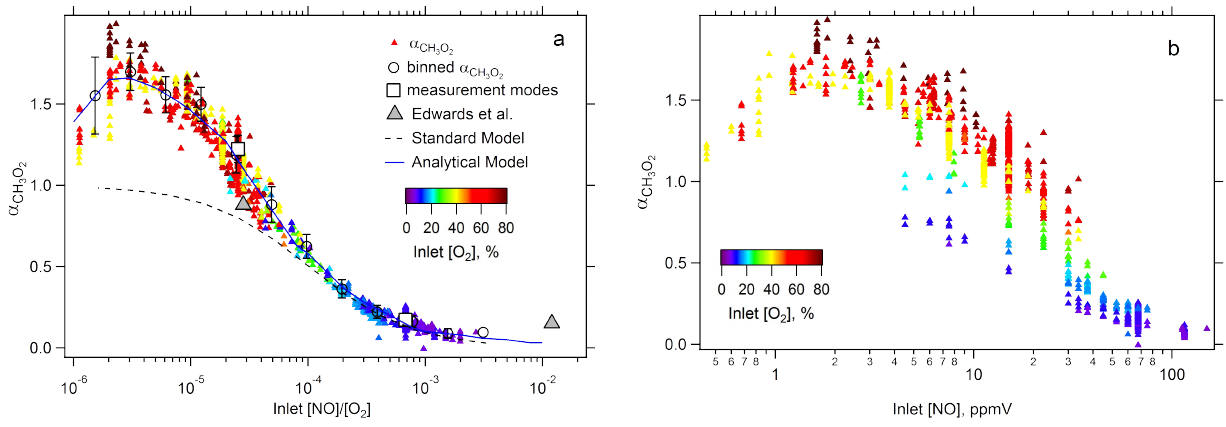
Fig. 3. Plot of measured α CH against (a) the ratio of [NO]/[O 2 ] in the inlet and (b) inlet [NO]. Individual measurements are shown as 3 O 2 small triangles, colored according to inlet O 2 concentration. In (a) the open black circles are the average measured α CH values binned 3 O 2 by [NO]/[O 2 ], with error bars showing the standard deviation for each bin. Squares are the mean α CH values for the two ambient 3 O 2 measurement modes. Large grey triangles are the literature α CH values reported by Edwards et al. (2003). Also shown are the standard 3 O 2 model (dashed curve) and the analytical model (solid blue curve) fit to the results.